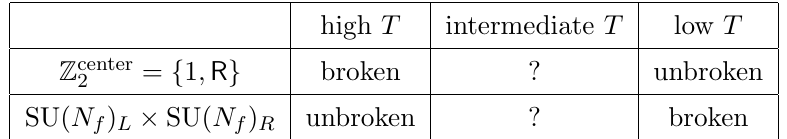
Table 1 . The temperature dependence of symmetry breaking/restoration. Here the \intermediate T " means that the temperature is within the range min( T chiral ; T center ) part of the four dimensional Lorentz group and hence it is unbroken. So there must be a phase transition which is a con(cid:12)nement/decon(cid:12)nement phase